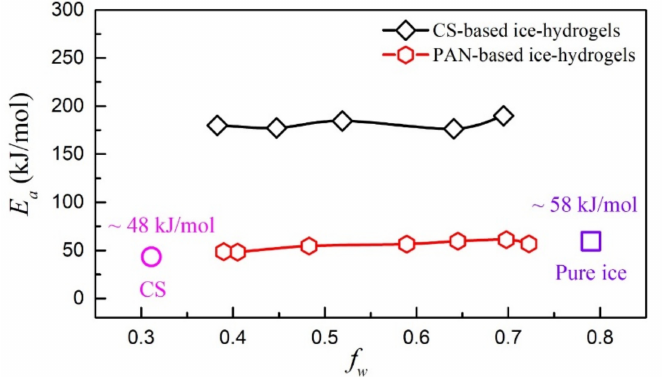
Figure 6. Activation energy ( E a ) as a function of water contents ( f w ) for covalent chitosan (CS)-based ice-hydrogels and non-covalent polyacrylonitrile (PAN)-based